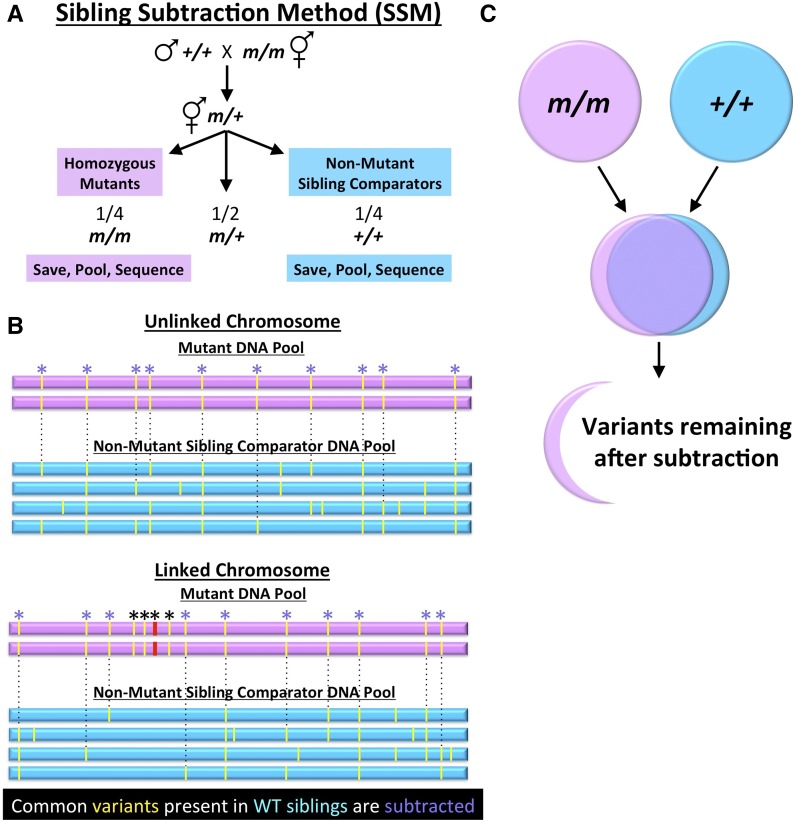
Schematic design of the SSM. (A) The genetic crosses required for generating multiple independent m/m and sibling +/+ isolates, which are combined to produce the mutant DNA pool and the nonmutant sibling comparator DNA pool, respectively (also see Figure S3). (B) Simplified representations of sequenced chromosomes from the mutant pool (pink) and nonmutant sibling comparator pool (blue) are shown. Yellow lines indicate variants detected by WGS, and asterisks indicate variants that are homozygous in the mutant pool. Note that the depiction underestimates the true number of variants per chromosome. Dashed lines and purple asterisks indicate variants that are present in both the mutant pool and the nonmutant sibling comparator pool, which can be eliminated (subtracted) as candidate causal mutations. Note that subtraction will remove most or all variants on unlinked chromosomes, whereas homozygous variants very close to the causal mutation (red) may not be subtracted (black asterisks). (C) Venn diagram of subtracted variants (purple) along with the relatively small proportion of remaining candidate variants (pink) after application of the SSM.